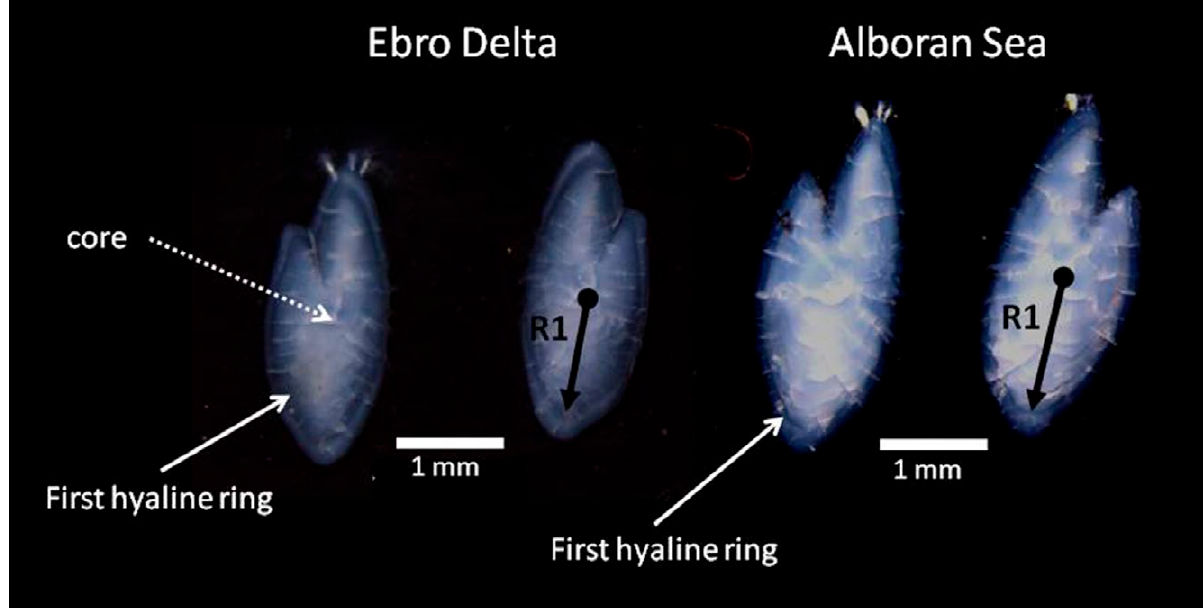
Fig. 2. – Typical morphology of anchovy otolith pairs found in GSA06 (Delta Ebro) and GSA01 (Alboran Sea), indicating the first hyaline ring and how the otolith first radio (R1) was